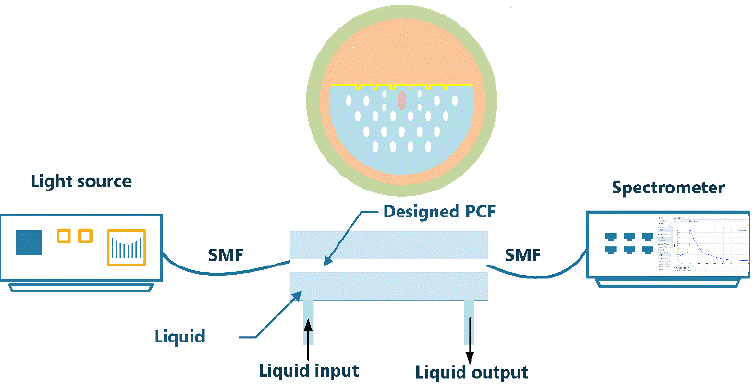
Figure 2. The experimental setup of the sensor.